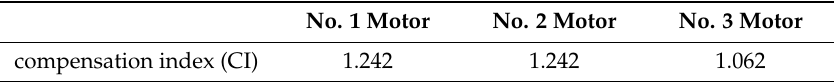
Table 2. Results of the acquired compensation indices (CIs) of the three stepper motors.